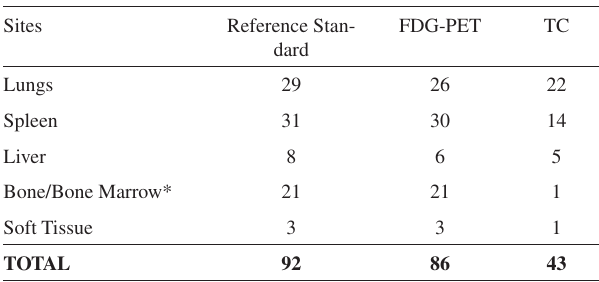
Table 3 - Region-based analysis of extranodal sites using CT and FDG-PET in 82 patients during initial staging